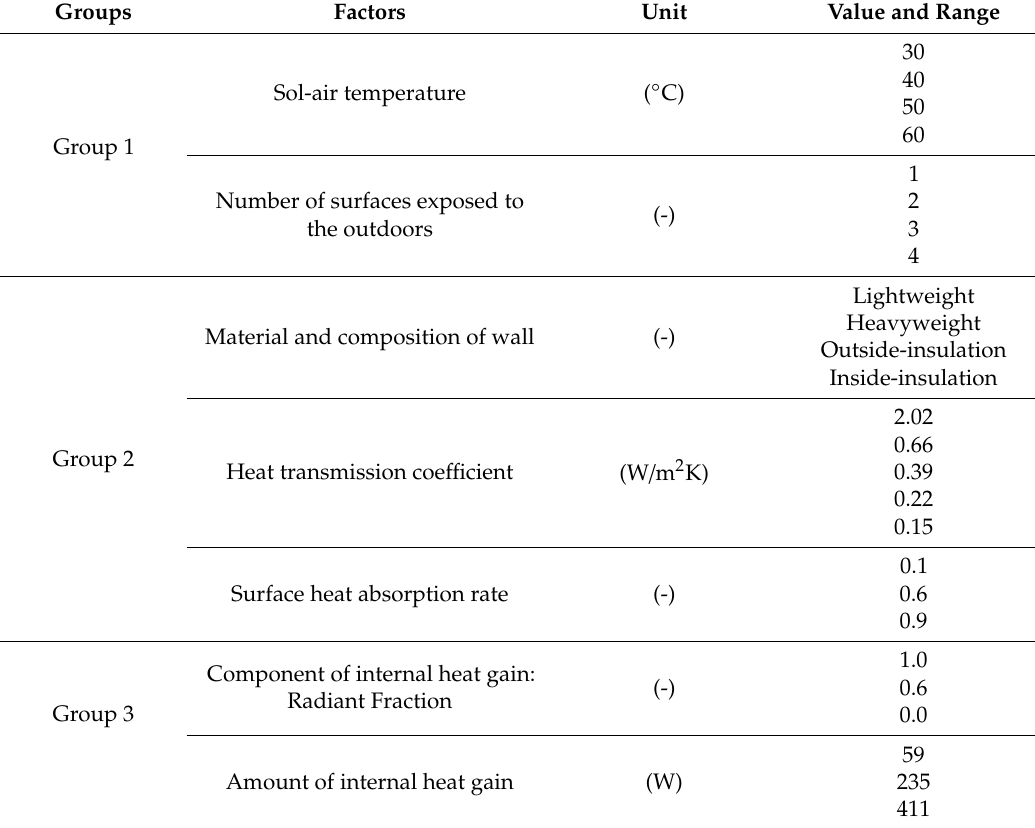
Table 5. Value of influencing